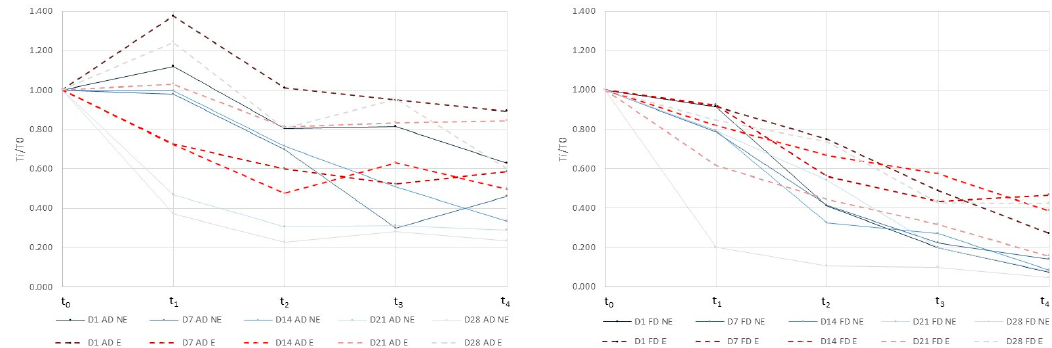
Figure 2. Relative content (T i /T 0 = CFU in t i /CFU in t 0 ) of L. salivarius spp. salivarius at each stage of the GI digestion process in air dried (left) and freeze dried (right) samples.